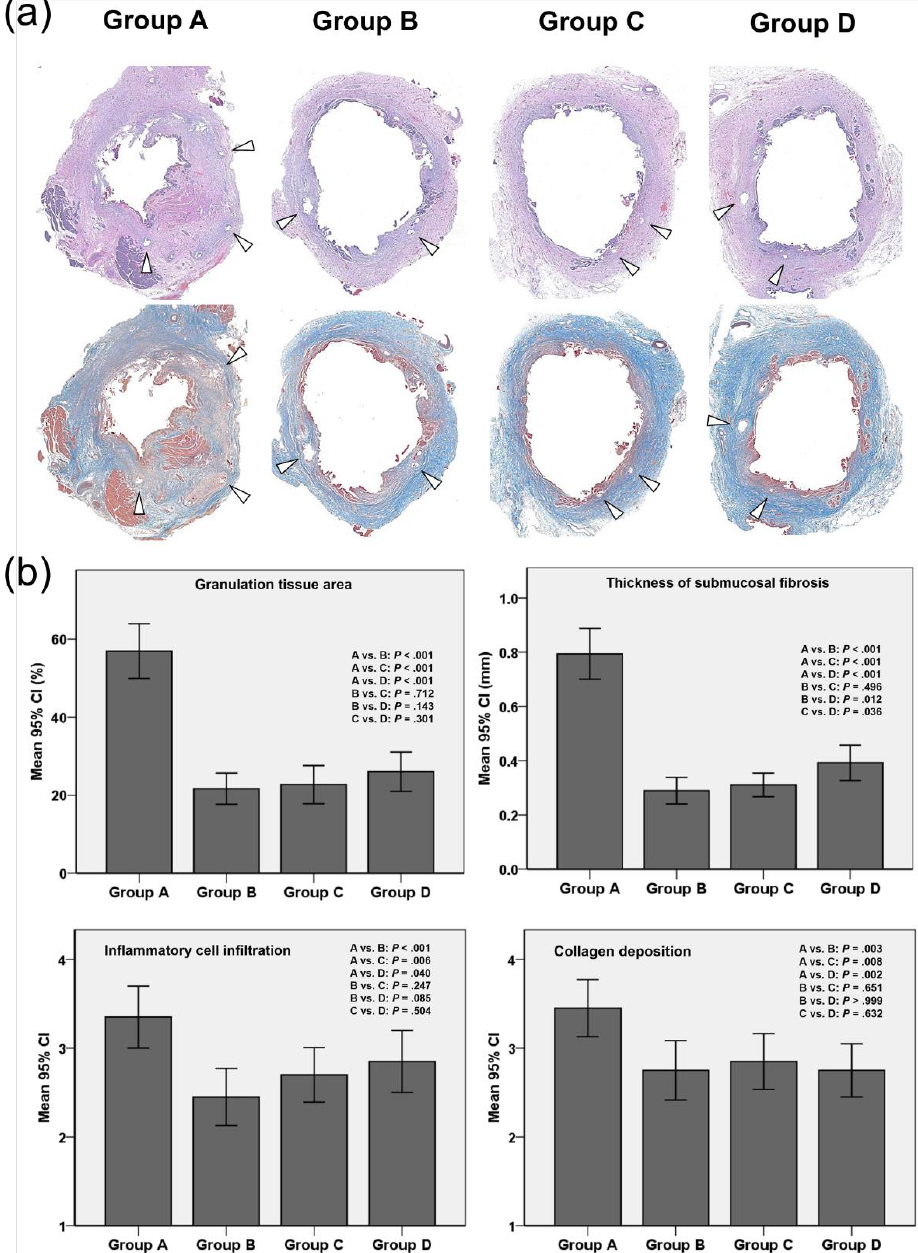
Figure 4. Histological findings. ( a ) Representative microscopic images (hematoxylin-eosin staining, magnification 1.25 × ) showing significantly higher granulation tissue in group A than in groups B, C, and D. Masson’s Trichrome staining showing significantly greater connective tissue in group A than in groups B, C, and D; arrowheads = stent struts. ( b ) Histopathologic results of the stented extrahepatic bile duct in groups A, B, C, and D. Note: CI, confidence interval.